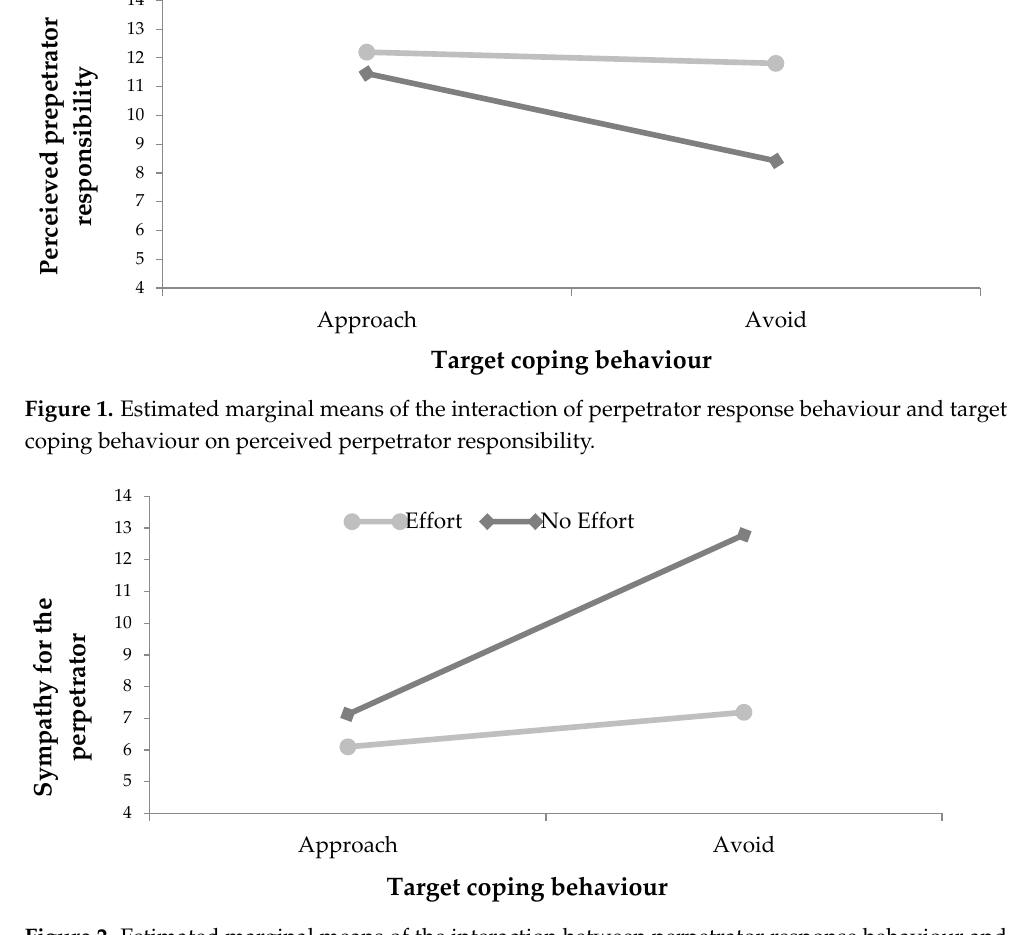
Figure 2. Estimated marginal means of the interaction between perpetrator response behaviour and target coping behaviour upon felt sympathy for the perpetrator.